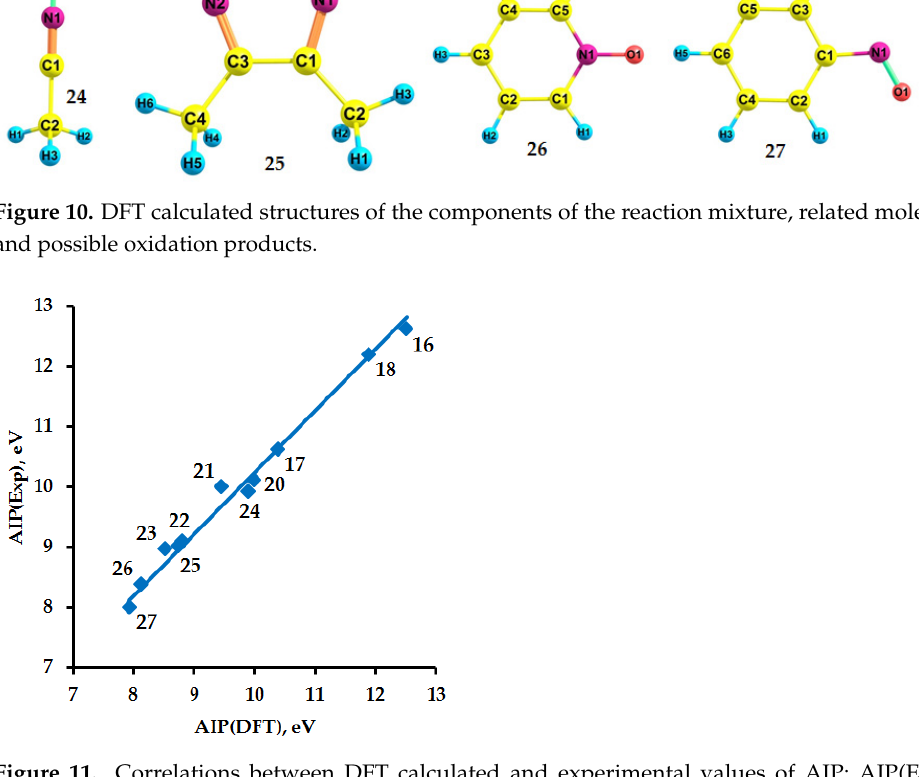
Figure 11. Correlations between DFT calculated and experimental values of AIP: AIP(Exp) = 1.0241AIP(DFT), R 2 = 0.9864. 1.0241AIP(DFT), R 2 =